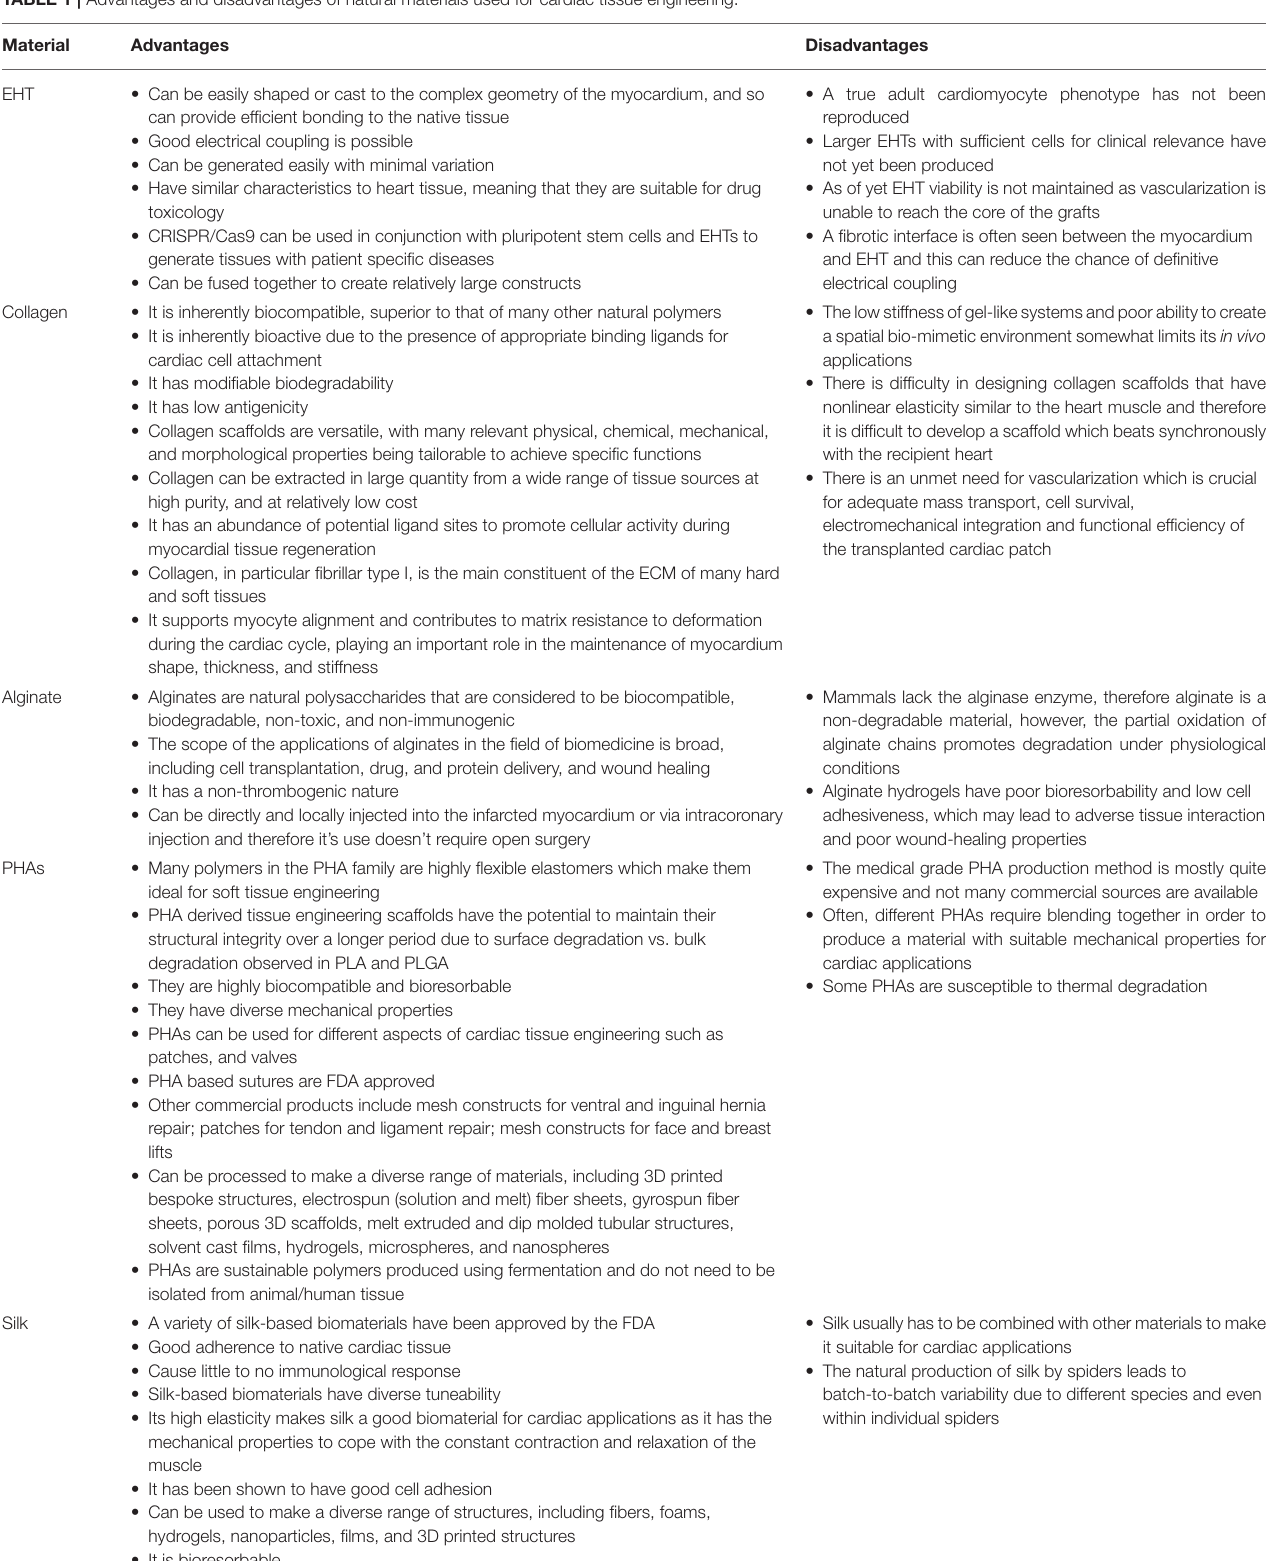
TABLE 1 | Advantages and disadvantages of natural materials used for cardiac tissue engineering.